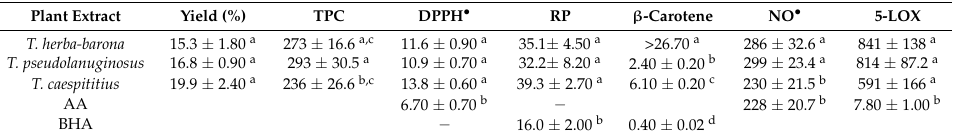
Table 1. Yield of extraction (%), total phenolic content (mg GAE/g of extract), and antioxidant and anti-inflammatory activities (EC 50 , µ g/mL) of T. herba-barona , T. pseudolanuginosus , and T. caespititius aqueous extracts.